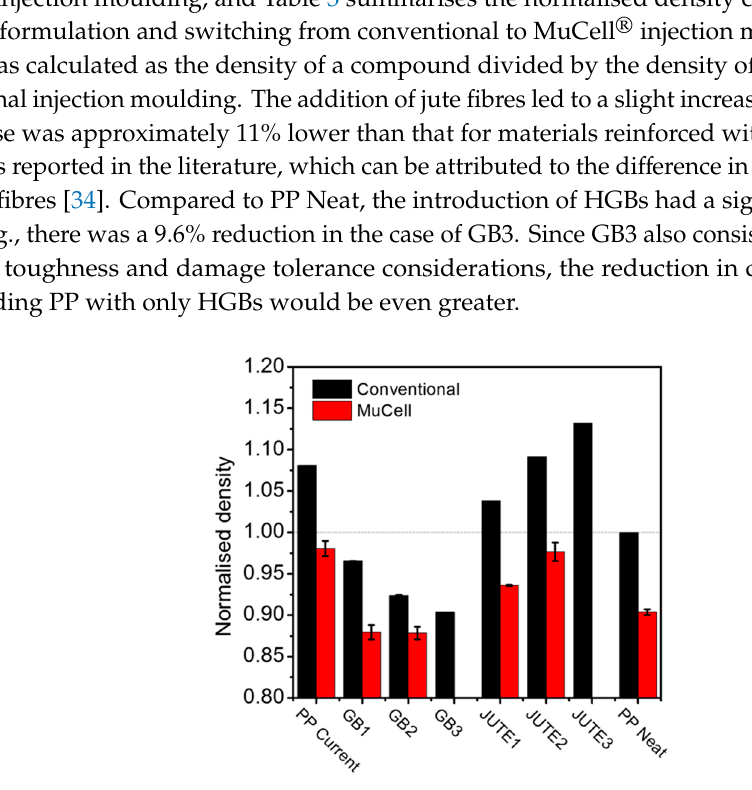
Figure 2. Normalised densities for PP Neat and di ff erent compounds using conventional and MuCell ®